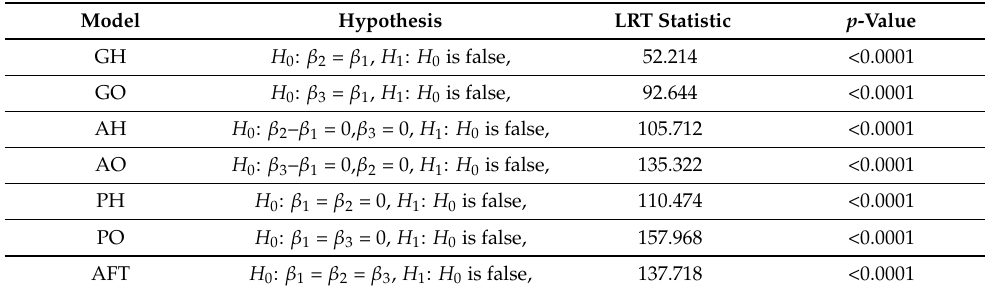
Table 5. LRT values for the AM class and its sub-models using IPASS dataset.